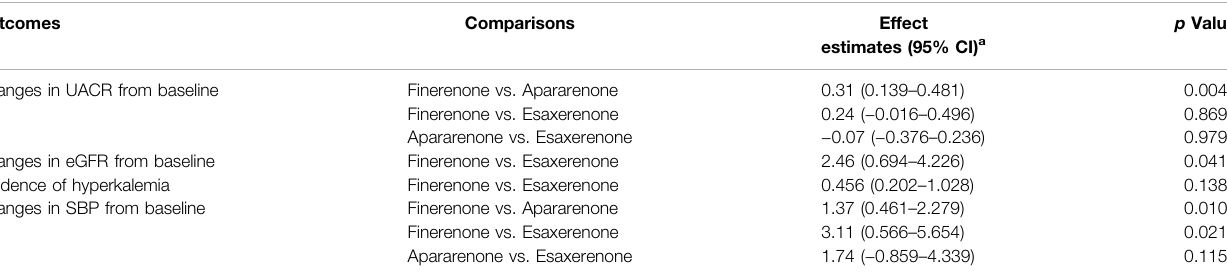
p Value estimates (95% CI) a